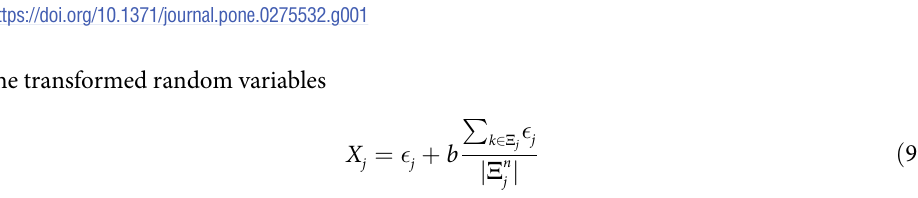
Fig 1. An example subgraph. The subgraph G I matrix procedure.